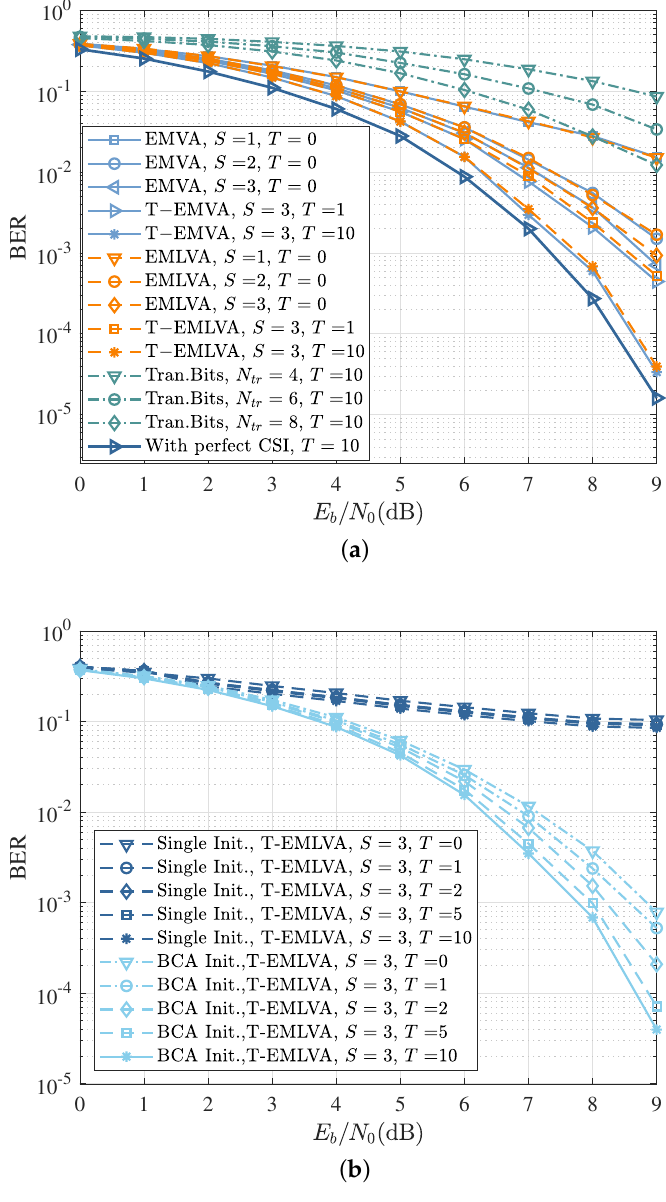
Figure 6. The performance of the EMLVA and T-EMLVA. ( a ) BER as a function of E b / N 0 for the EMLVA and T-EMLVA with the BCA initializer. The “With perfect CSI” and “Tran. Bits” curves refer to the performance of the optimal coherent detector and training-based channel estimation, respectively; ( b ) BER as a function of E b / N 0 for the EMLVA and T-EMLVA with different